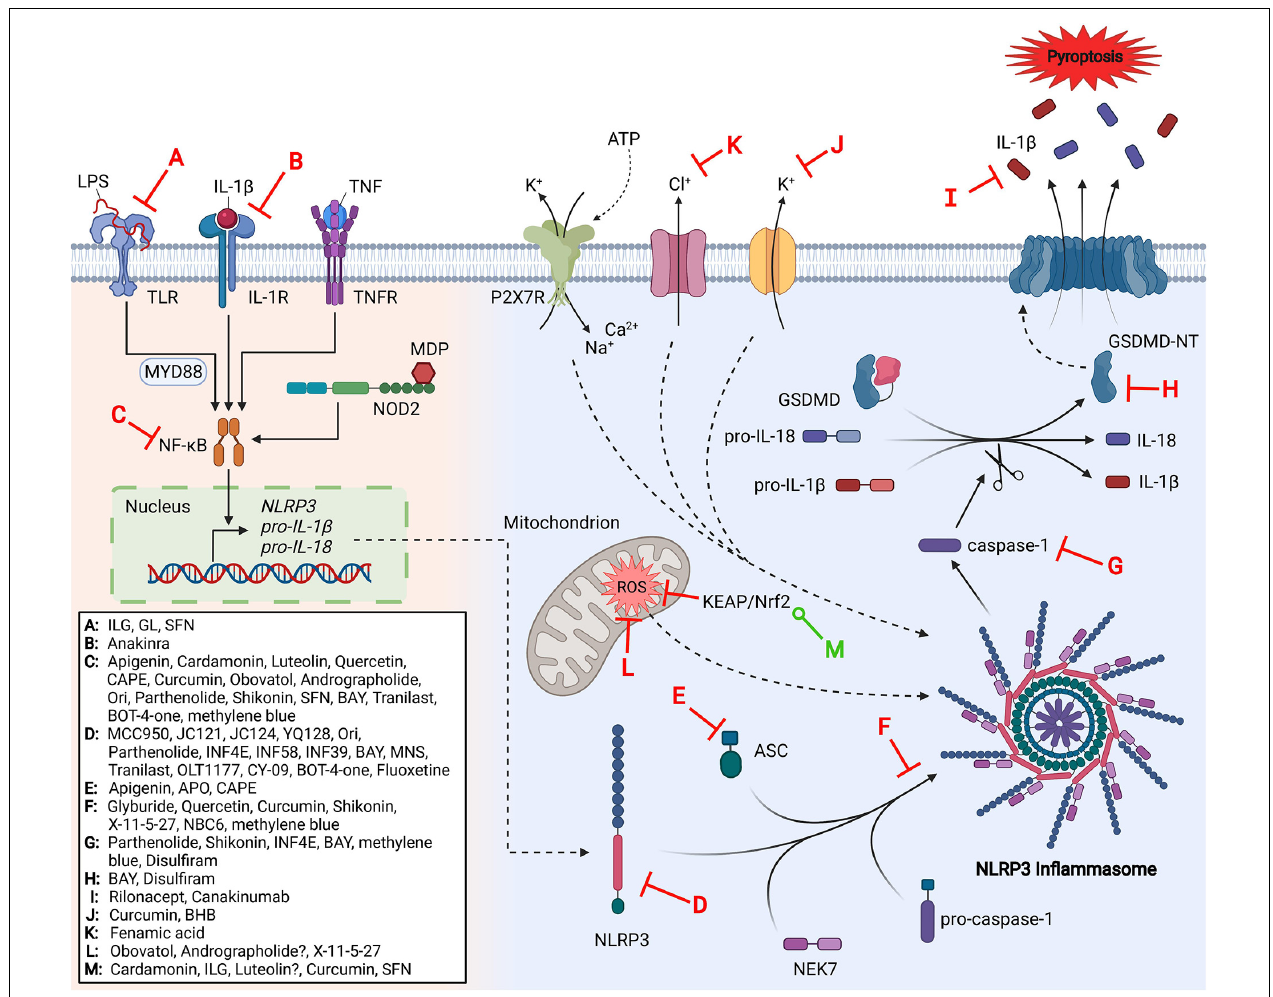
FIGURE 1 | The NLRP3 inflammasome pathway and its